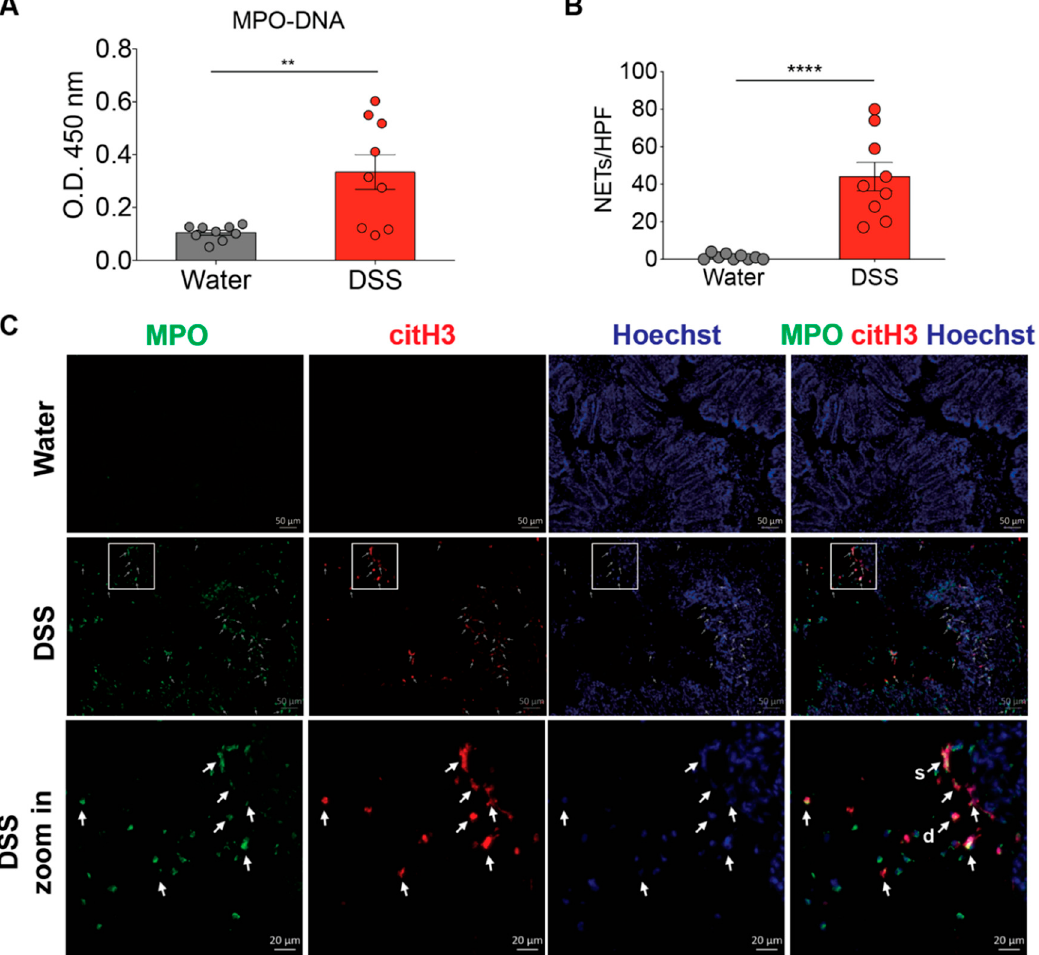
Figure 1. Neutrophil extracellular traps (NETs) are induced in the colon of dextran sulfate sodium (DSS)-treated mice. ( A ) NET release was measured in colon homogenates of wild-type C57BL/6 mice 8 d after the consumption of clean water or 2.5% DSS, by using myeloperoxidase (MPO)-DNA ELISA. (The results are pooled data from two separate experiments. n = 9 mice per group.) ( B , C ) NET formation counts per 200X high-power field (HPF) and representative NET release (white arrows) in the colon of wild-type C57BL/6 mice 8 d after the consumption of clean water or 2.5% DSS, assessed by immunofluorescence microscopy of MPO (green), citrullinated histone H3 (citH3; red), and Hoechst 33342-stained DNA (blue). Bottom row, enlargement of the area outlined in the second-row